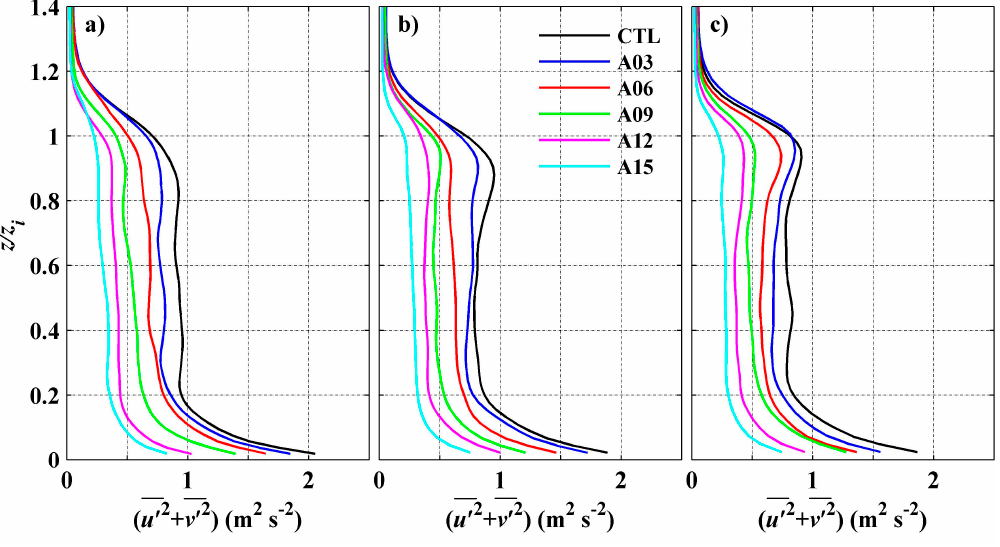
Figure 9. Profiles of total horizontal velocity variance ( u (cid:48) 2 + v (cid:48) 2 ) for the cases with three different stratification strengths in the free atmosphere: ( a ) 3 K km − 1 , ( b ) 6 K km − 1 , and ( c ) 9 K km − 1 . The color scheme for cases with different AOD is the same as in Figure 8.